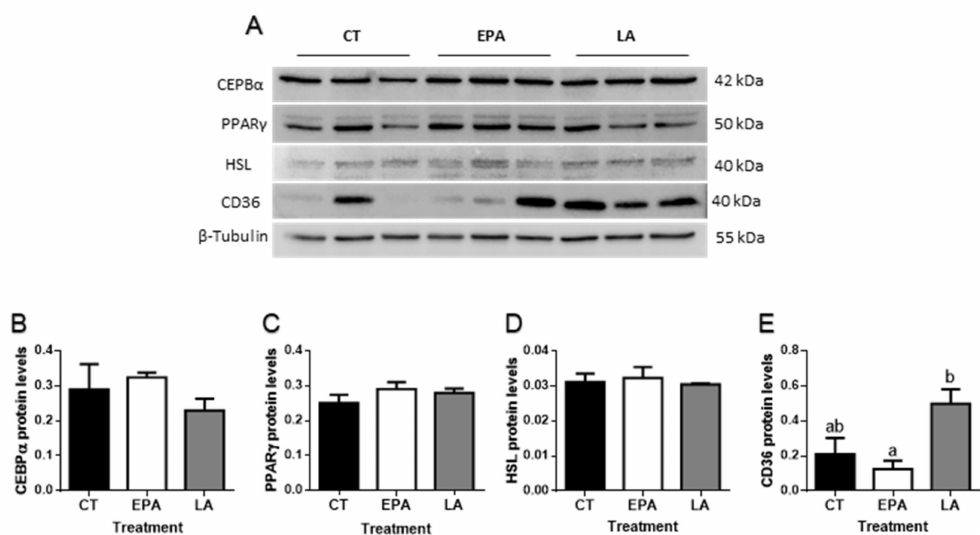
Figure 4. ( A ) Representative Western blots of the transcription factors CEBP α and PPAR γ , the enzyme HSL, the fatty acid translocase CD36, and β -tubulin in adipose tissue of rainbow trout at 6 h after being force-fed with EPA, LA, or vehicle without fatty acid as control. Quantification of the protein levels of ( B ) CEBP α , ( C ) PPAR γ , ( D ) HSL, and ( E ) CD36 normalized to β -tubulin. Data are shown as mean + SEM ( n = 6). Significant di ff erences ( p < 0.05) among treatments are indicated by di ff erent letters (a,b). CT: control; EPA: eicosapentaenoic acid; LA: linoleic